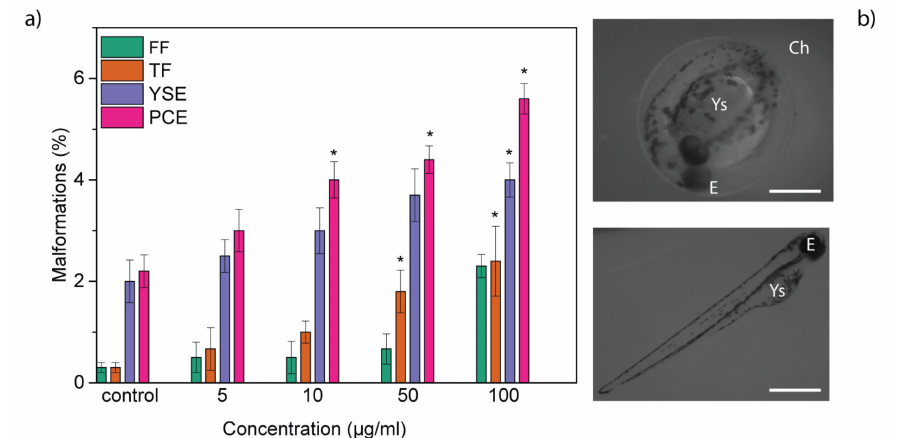
Figure 4. ( a ) Malformations induced in zebrafish exposed to GL layers; (* p < 0.01); and ( b ) microscopic images of zebrafish embryo at 48 hpf and larvae at 96 hpf treated with 100 ppm of GL layers. Scale bar = 500 µ m. Ch: chorion; E: Eye; Ys: yolk